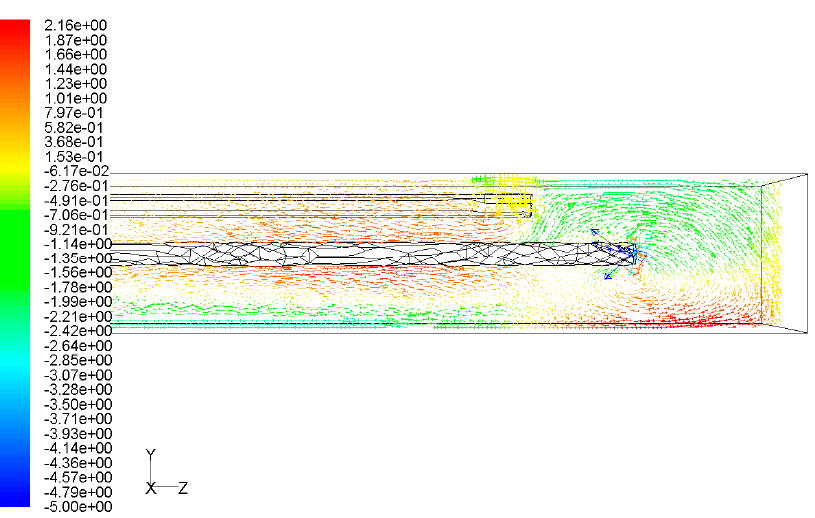
Figure 10. Airflow velocity vector at 1.5 m above the floor (m/s).